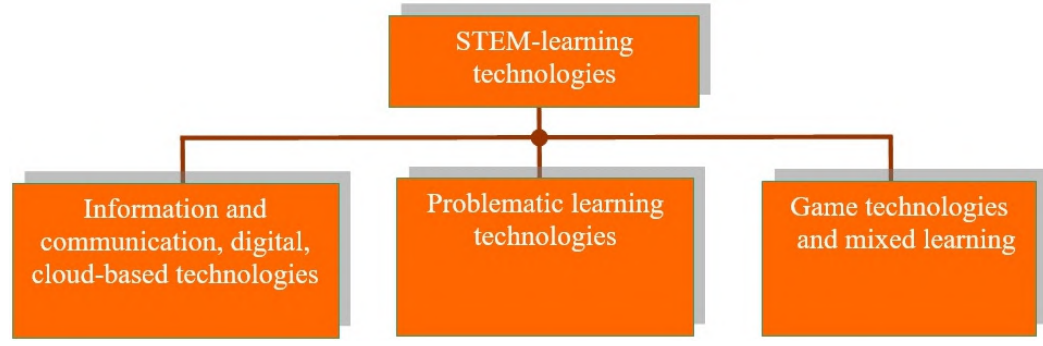
Figure 1: Classification of STEM technologies for teaching